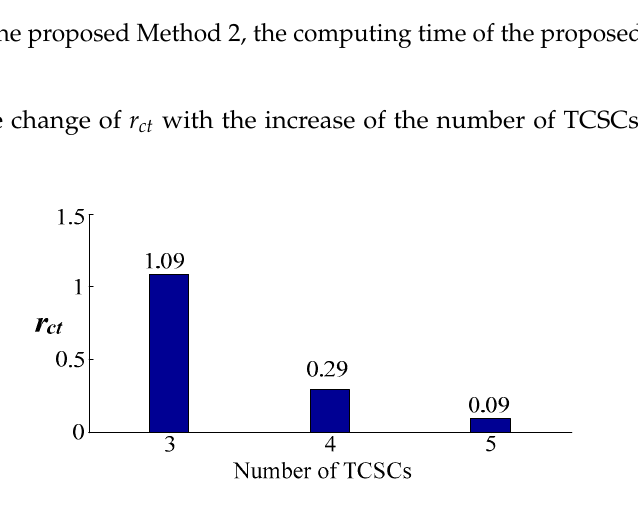
Table 6. Comparison of computing time with the change of TCSC number.